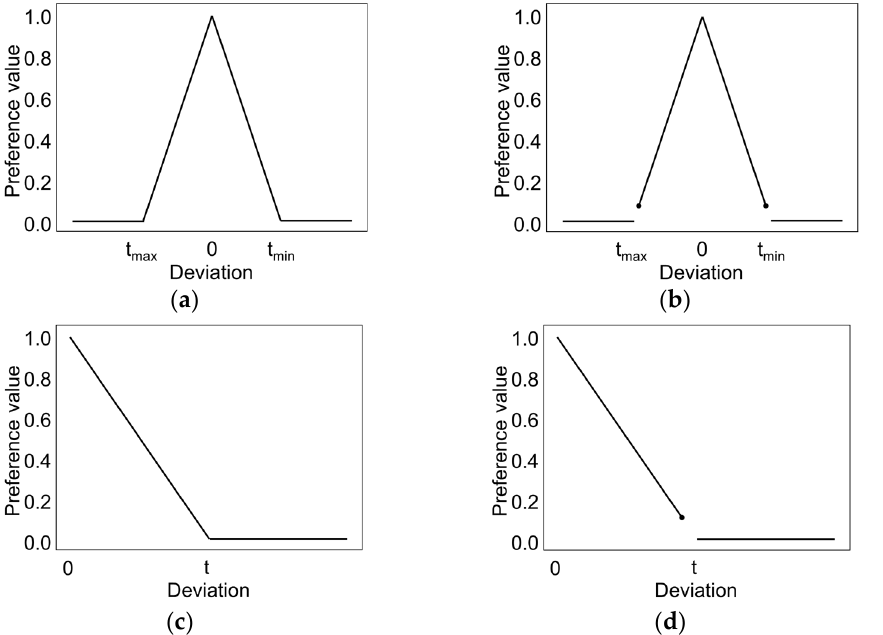
Figure 5. Graphs of ( a ) the preference function for the indicators MIN, MAX, AVG; ( b ) the minimising preference function for the indicators MIN, MAX, AVG; ( c ) the preference function for the SIGMA and TOTALFAIL indicators; ( d ) the graph of the minimising preference function for the SIGMA and TOTALFAIL indicators.